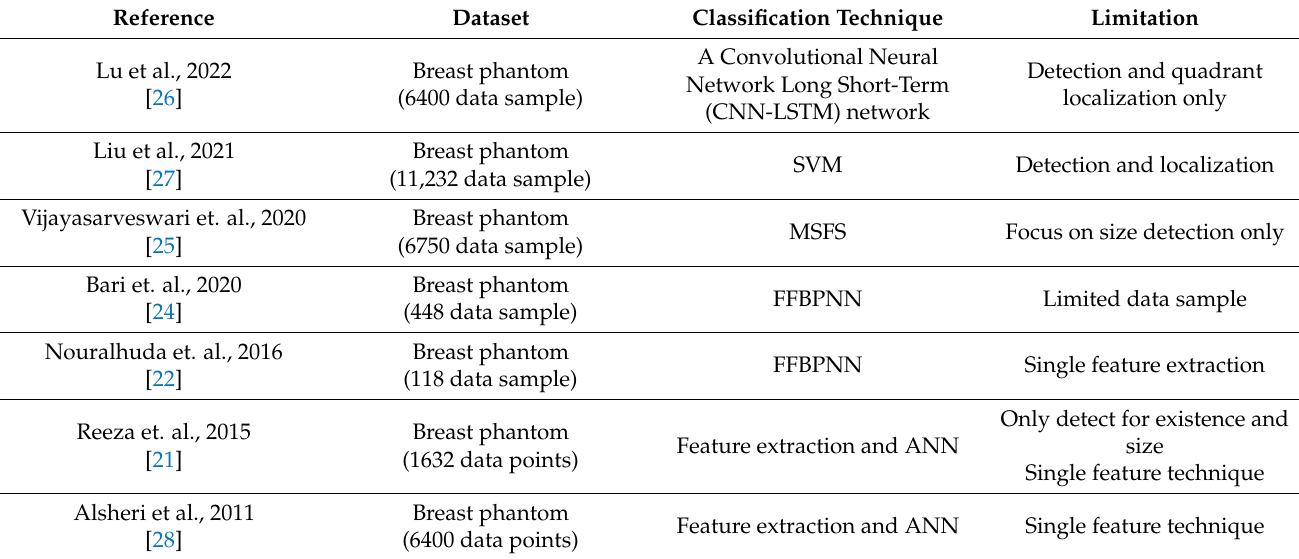
Table 1. Summary of the previous study on breast cancer detection using